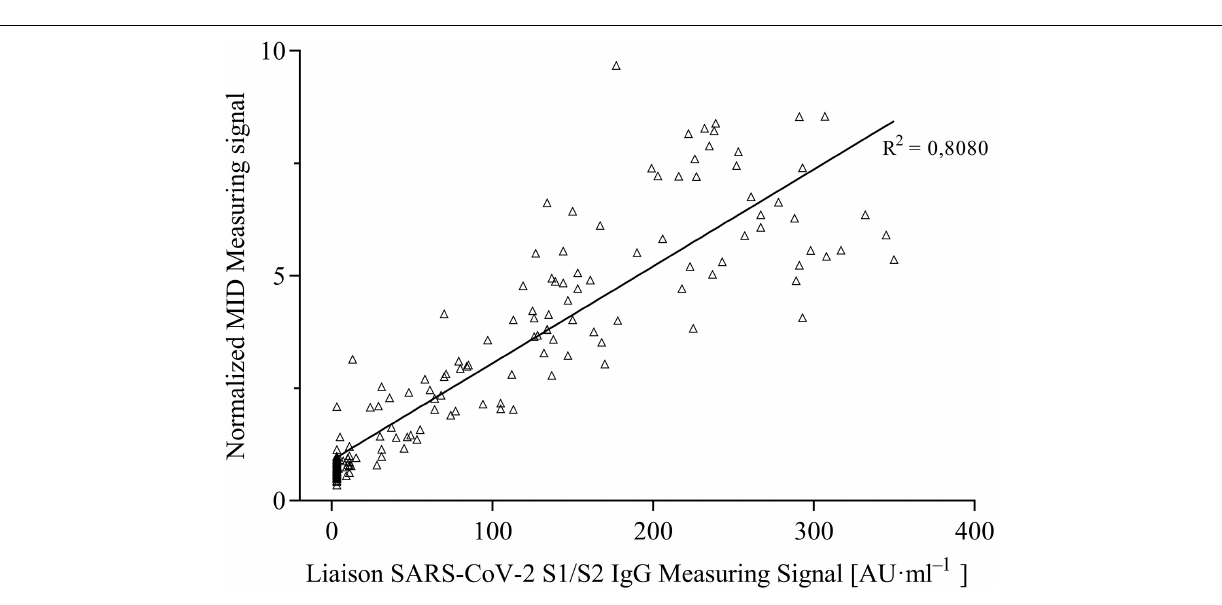
Frontiers in Microbiology |